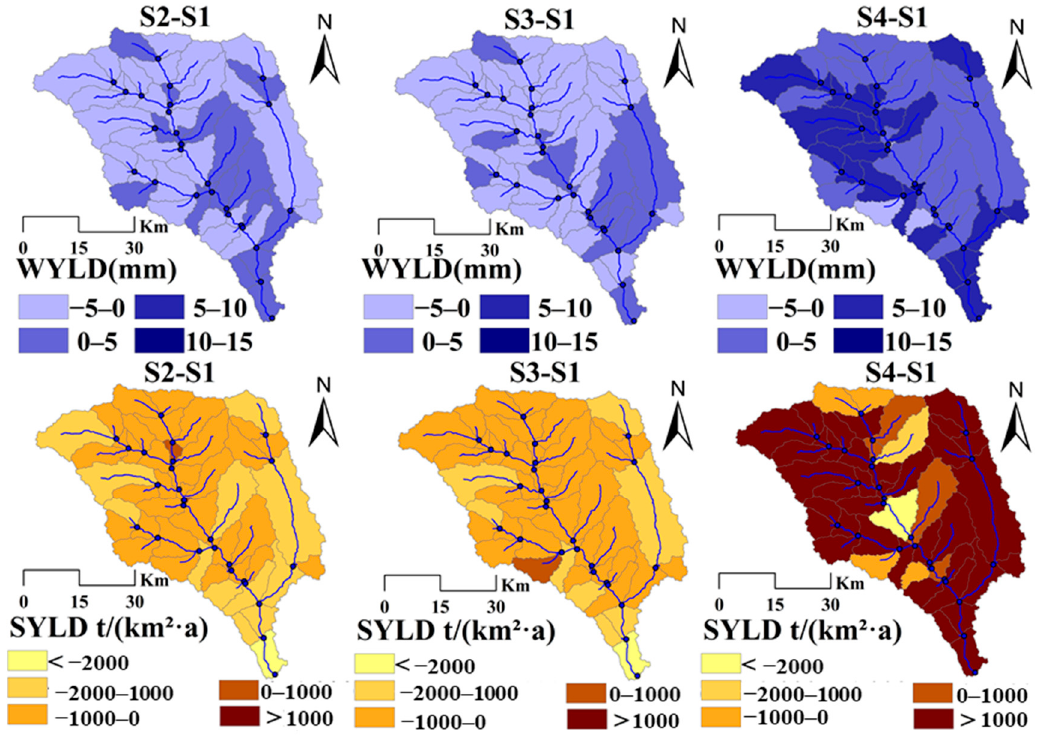
Figure 9. Spatial distribution of the di ff erence values in water yield and sediment yield between S2, S3, S4, and